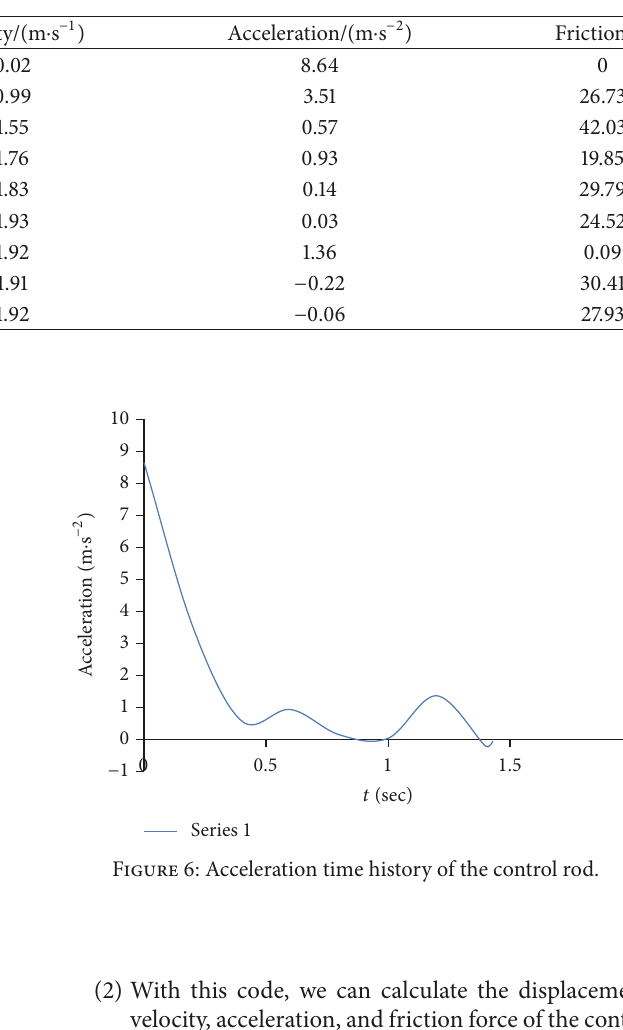
Table 1: Displacement, velocity, acceleration, and friction of the control rod at each time.